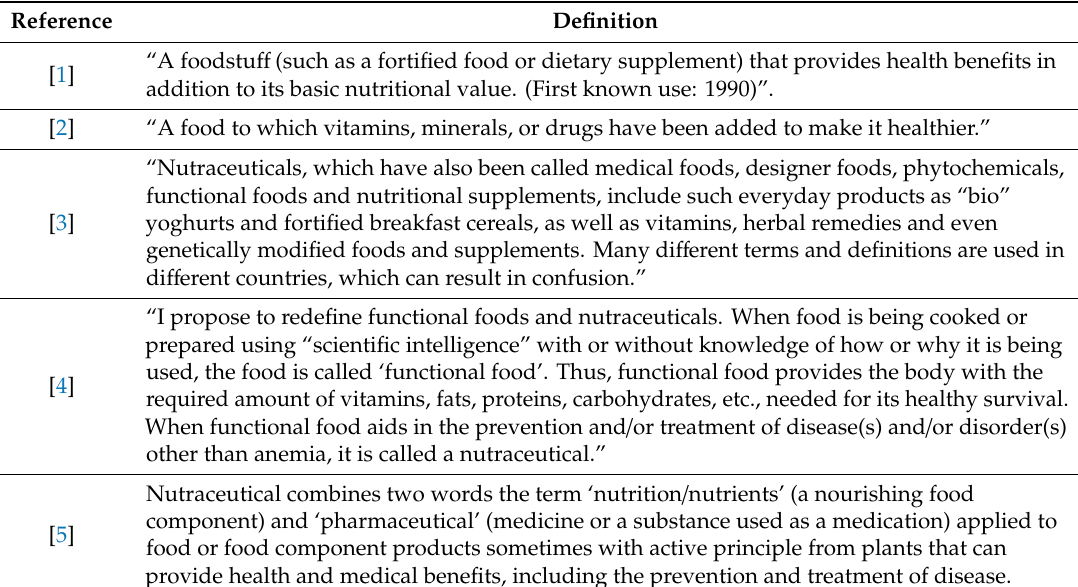
Table 1. Some definitions of